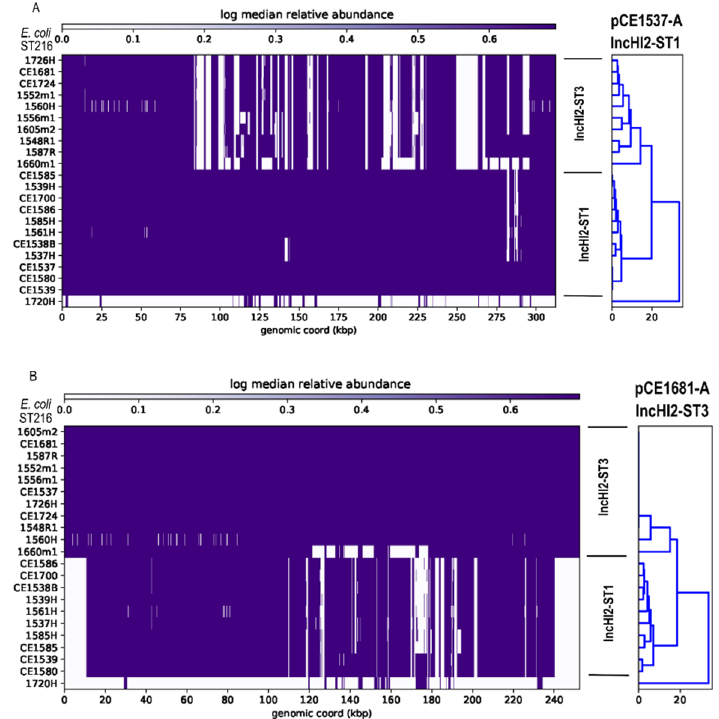
Figure 5. Heat maps showing the distribution of reference plasmids within sequenced short reads of E. coli ST216 isolates from silver gulls at Five Islands. Blue colour indicates the coverage profile of each short read with respect to the reference plasmid. Reference plasmids: ( A ) pCE1537-A (IncHI2-ST1) and ( B ) pCE1681-A